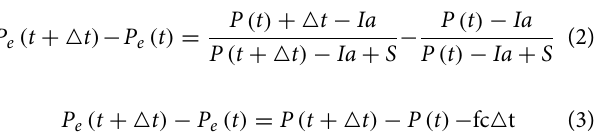
Gregoretti and Dalla Fontana (2008) and are shown in Figure 5